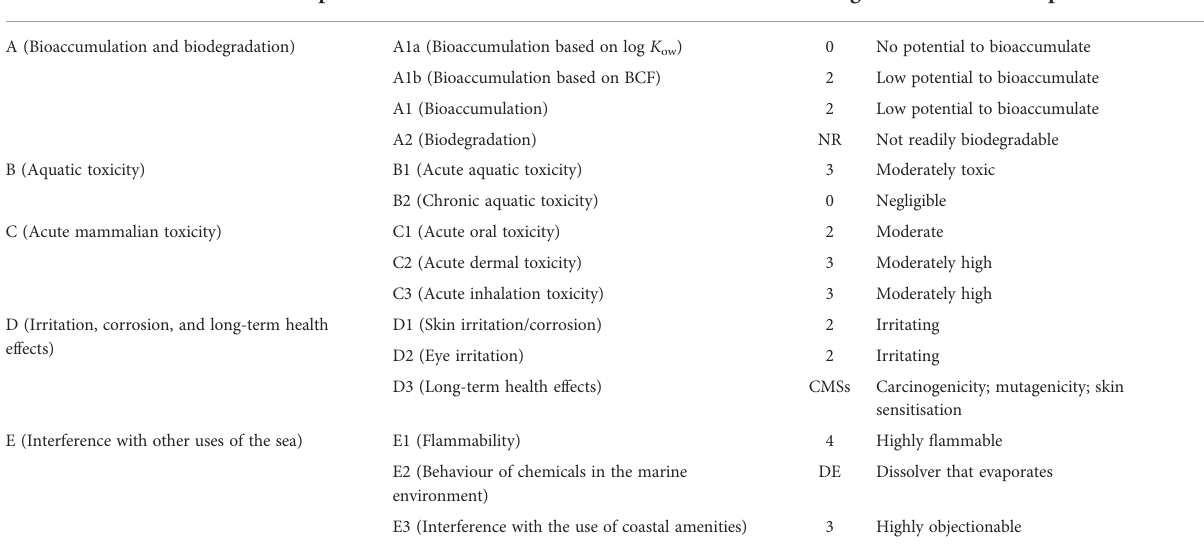
TABLE 1 GESAMP hazard pro fi les of